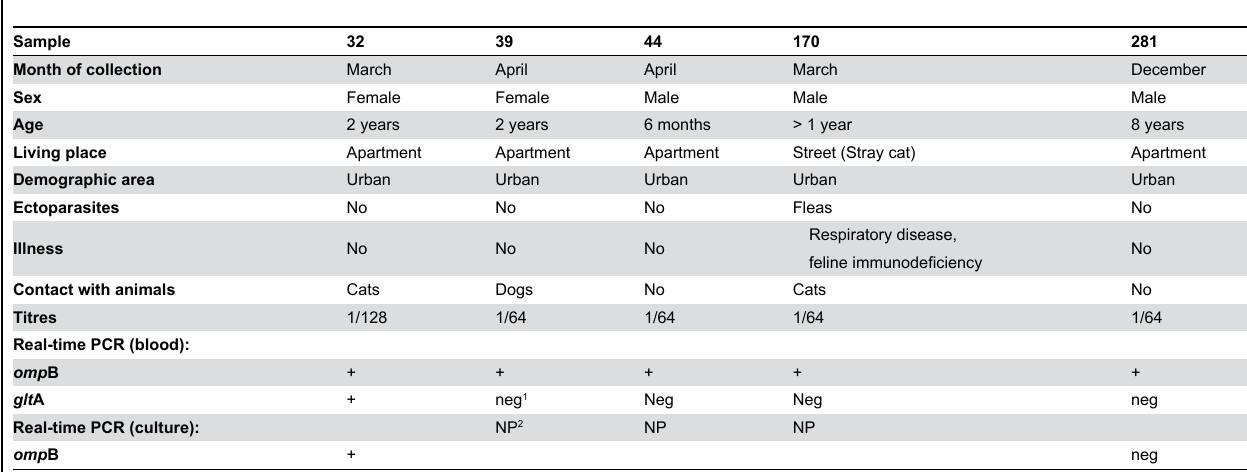
Table 2. Demographic information from cats with positive results by molecular